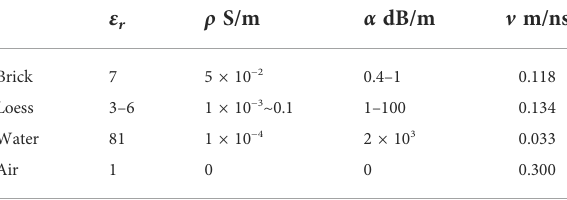
TABLE 1 Dielectric parameters of common construction materials (Lv et al., 2018b).